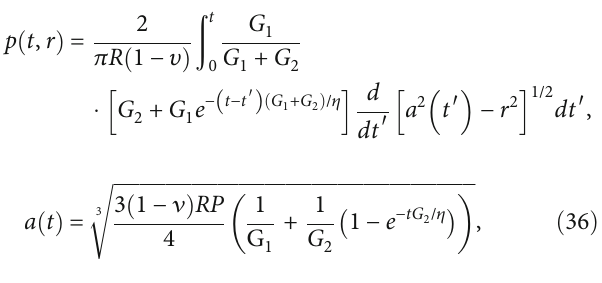
= 3000 μ m , which c